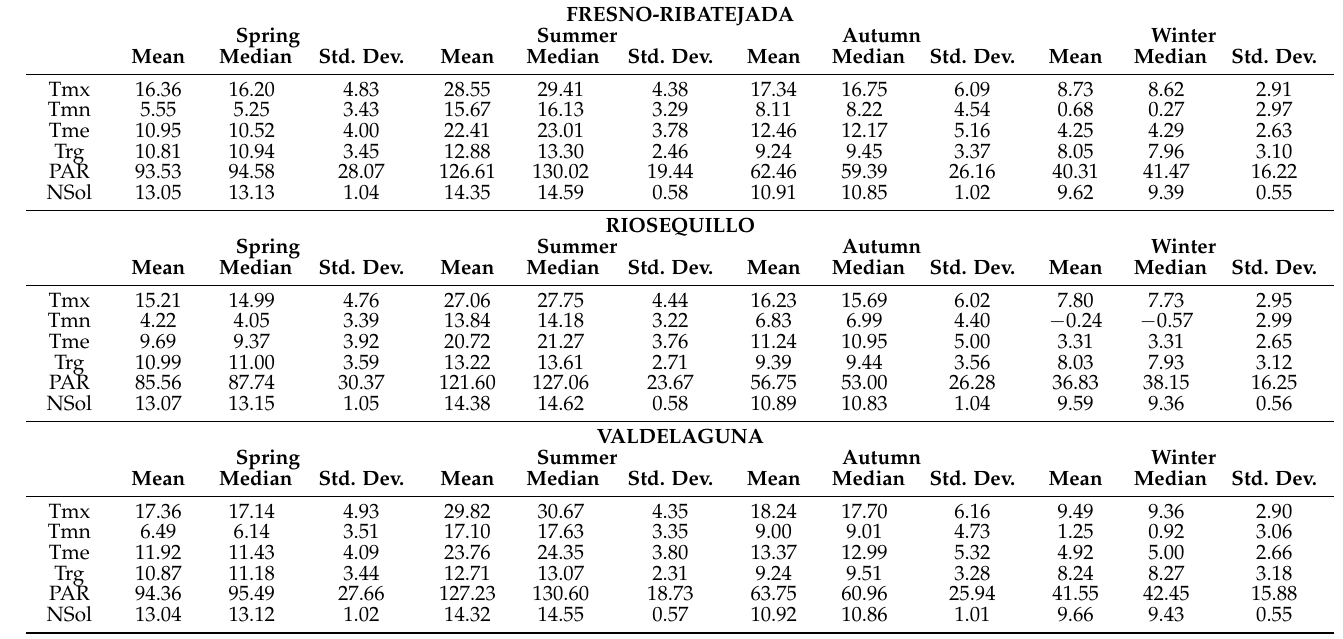
Table A1. Long-term data statistics for four sites.